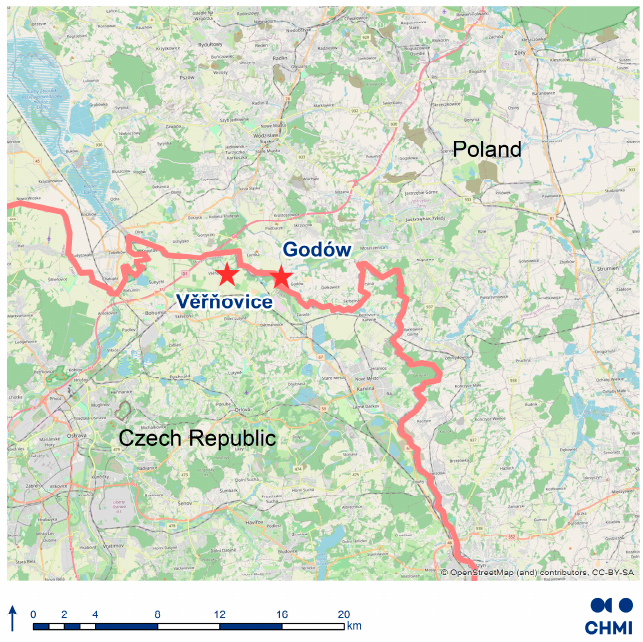
Figure 2. The assessed site location within the Czech–Polish border region.